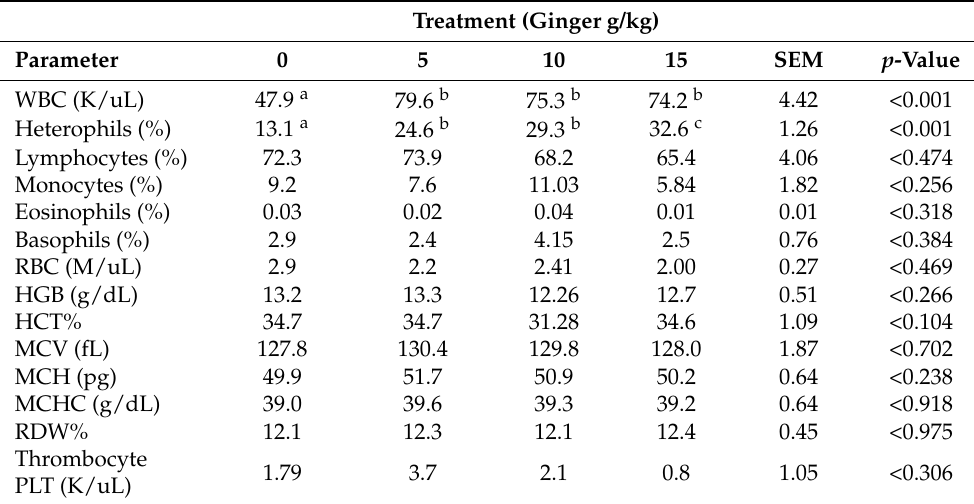
Table 7. Hematological and biochemical parameters of broilers fed ginger powder.